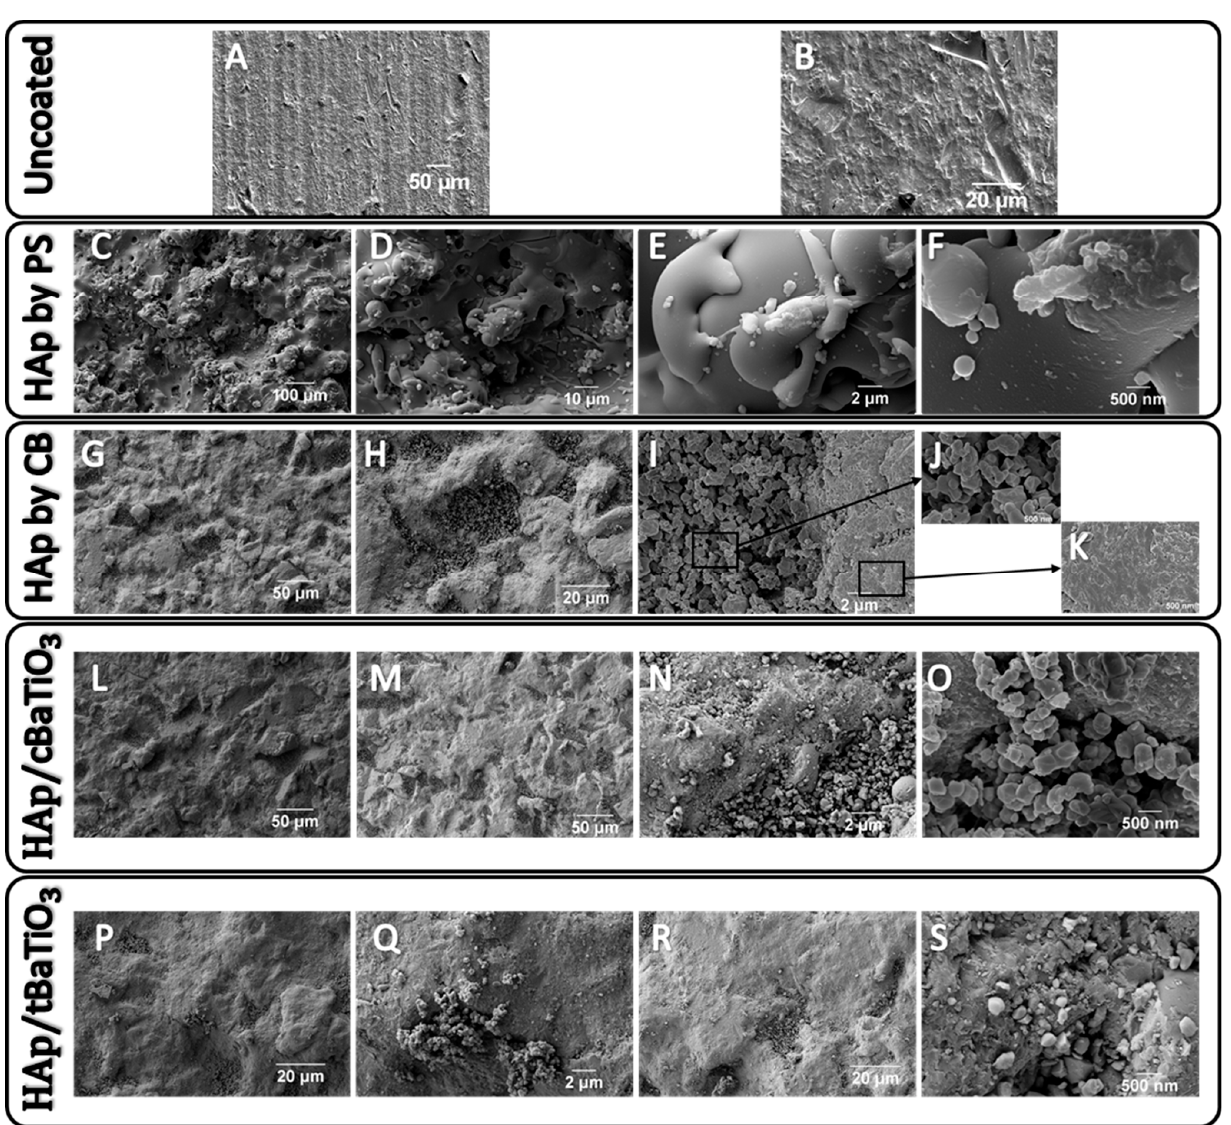
Figure 4. SEM images of samples without coating ( A , B ) and with coatings by Plasma Spray with HAp ( C – F ), by CoBlast TM with HAp ( G – K ), HAp/cBaTiO 3 ( L – O ) and HAp/tBaTiO 3 ( P – S ).